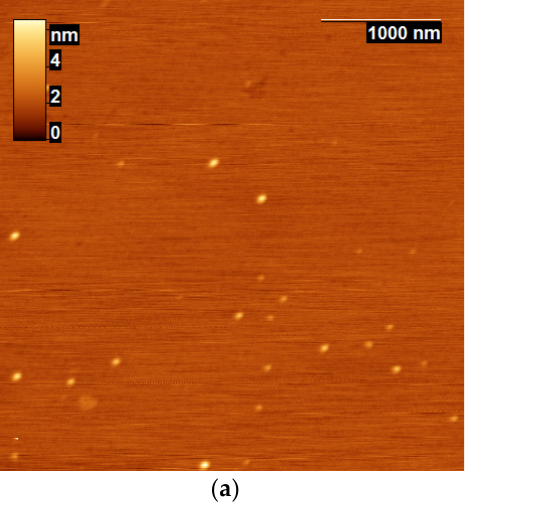
Figure 1. Topographic images of β -CN nanoparticles digested with trypsin for 90 min, followed by heat inactivation of trypsin activity ( a , sample 1) or inaction of trypsin activity with soybean trypsin inhibitor ( b , sample 2).